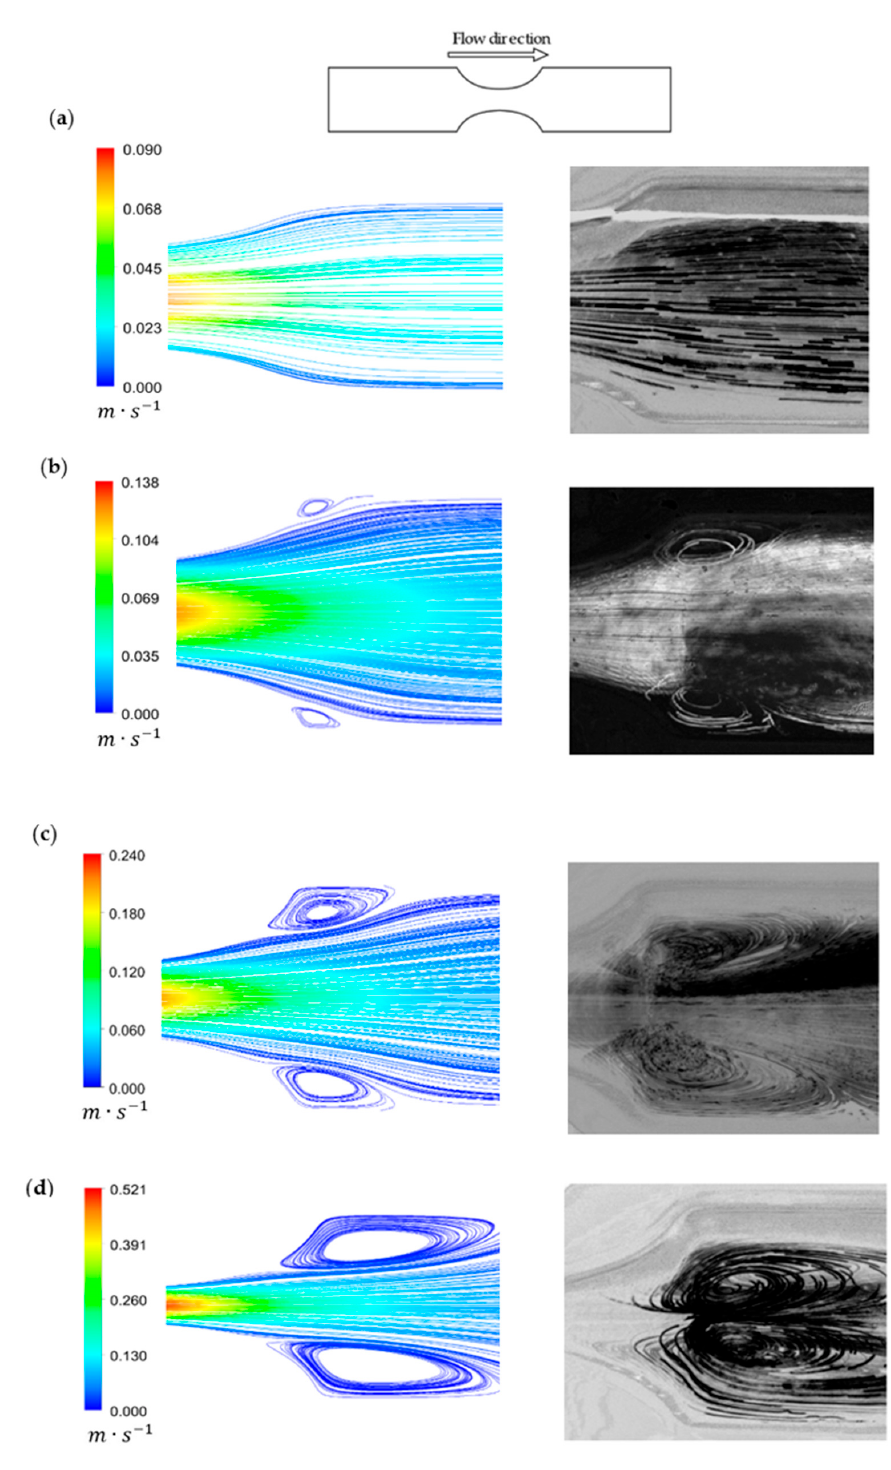
Figure 10. Streamlines for different degrees of stenosis: ( a ) 50%, ( b ) 60%, ( c ) 70%, and ( d ) 80%. Left: Left: Numerical velocity streamlines; Right: Z Project Numerical velocity streamlines; Right: Z Project streamlines.